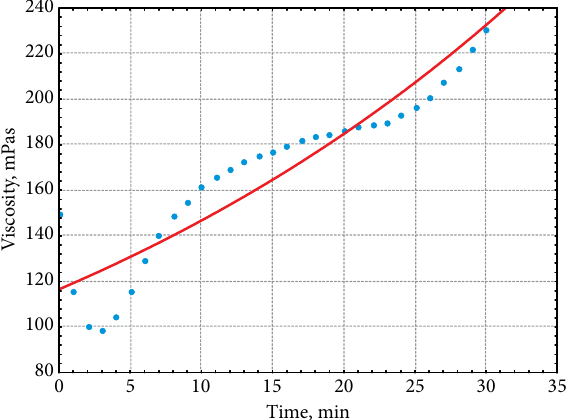
Fig. 5. The relationship between viscosity and time in cement paste with no synthetic zeolite